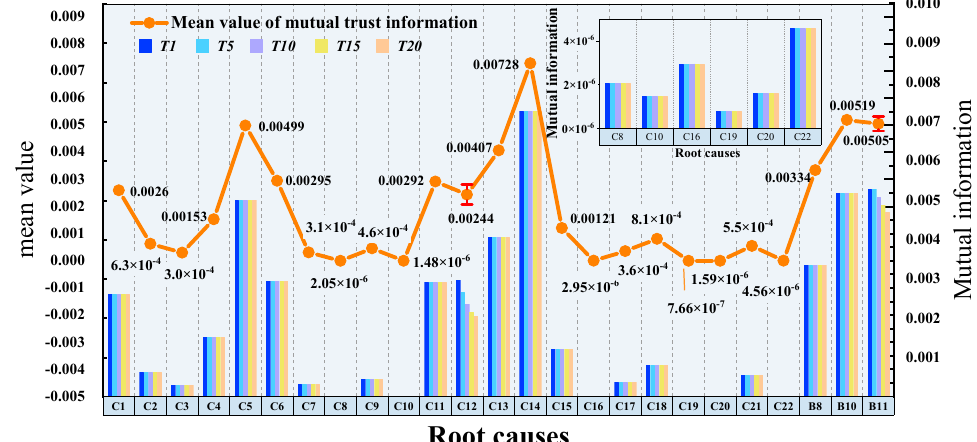
Figure 15. Mutual information of root nodes (risk factors).